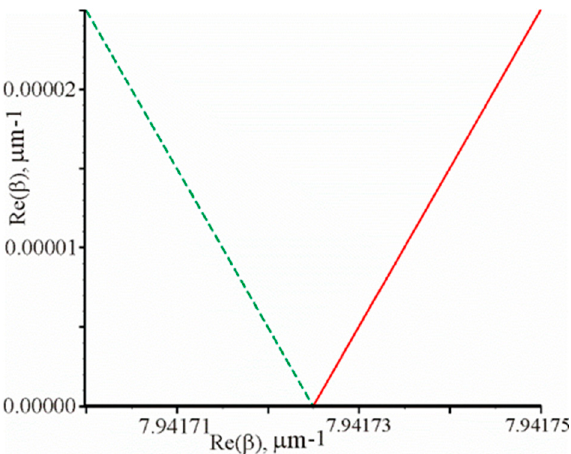
Figure 3. Graphical dependencies Re ( F ( x , y )) = 0 (solid line) and Im ( F ( x , y )) = 0 (dotted line) at the prism structure parameters mentioned